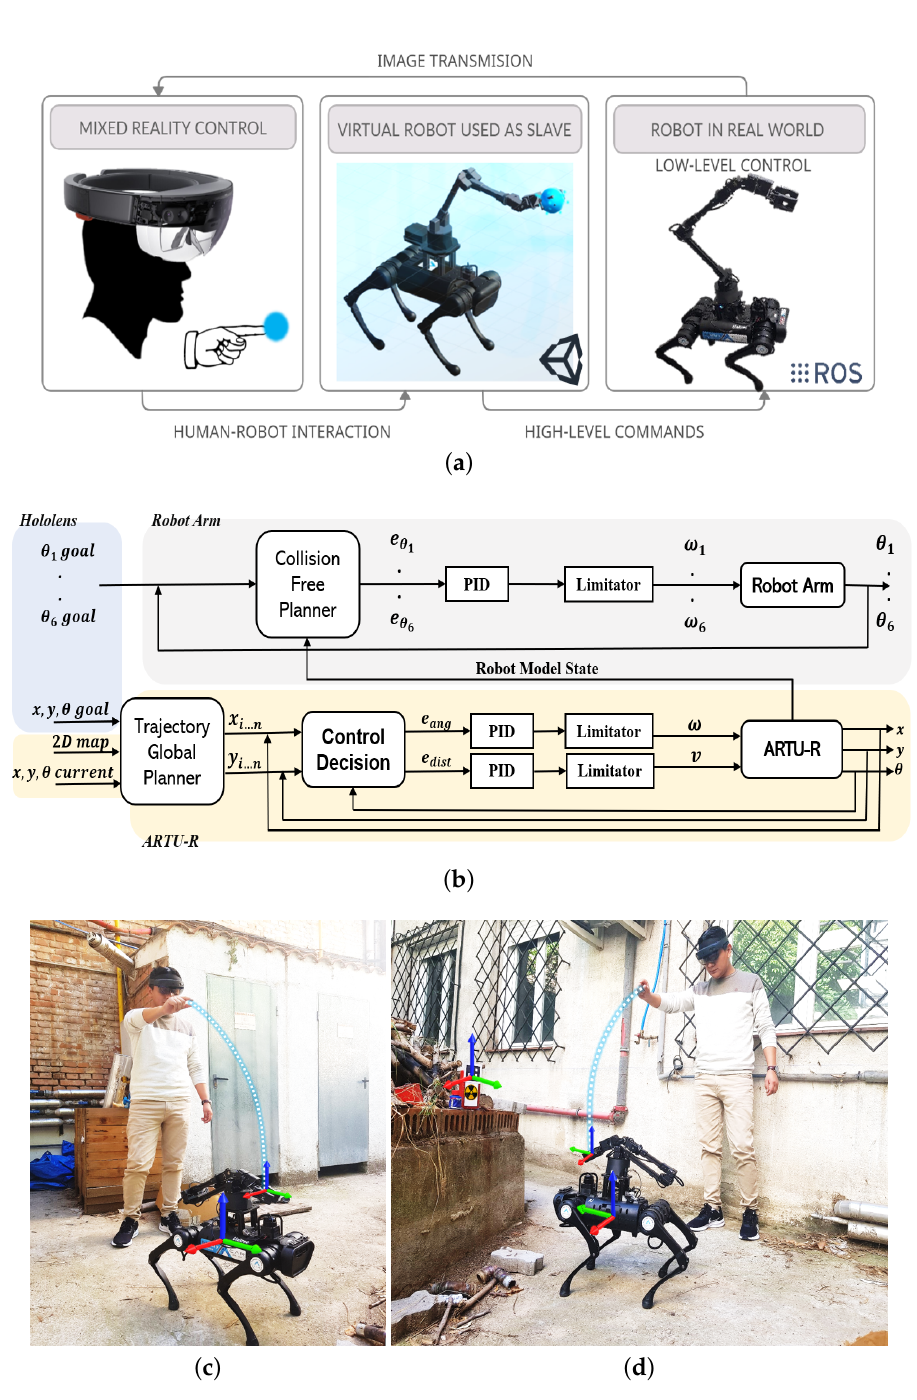
Figure 4. Description of the Mixed-Reality system for tele-operation of the robotic set. ( a ) Systematic scheme of tele-operation of the robot-manipulator through Mixed-Reality. ( b ) Systematic scheme of tele-operation of the robot-manipulator through Mixed-Reality. ( c ) Schematic reference systems repre- sentation of the quadruped robot and the tele-operated manipulator arm-Frontal View. ( d ) Schematic reference systems representation of the quadruped robot and the tele-operated manipulator arm- Lateral